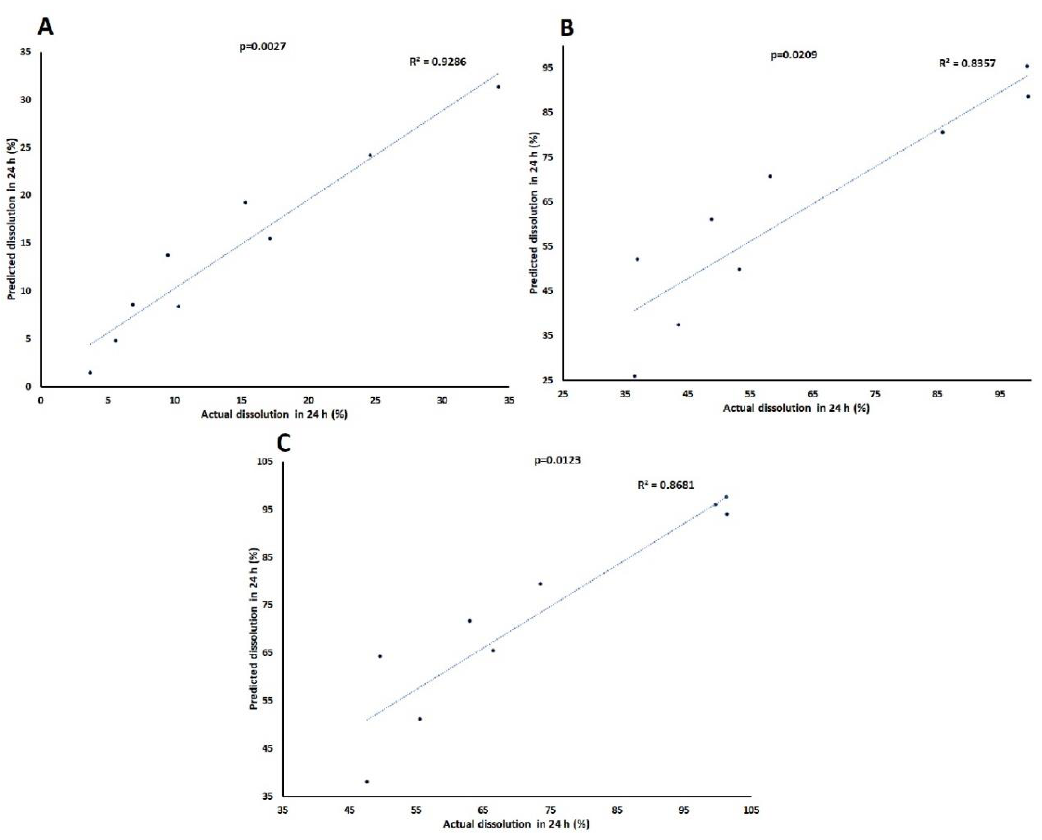
Figure 4. Actual and model predicted curve of ( A ) Y 1 , ( B ) Y 2 , and ( C ) Y 3 tablets coated with CAB 171-15/C-A-P blend.